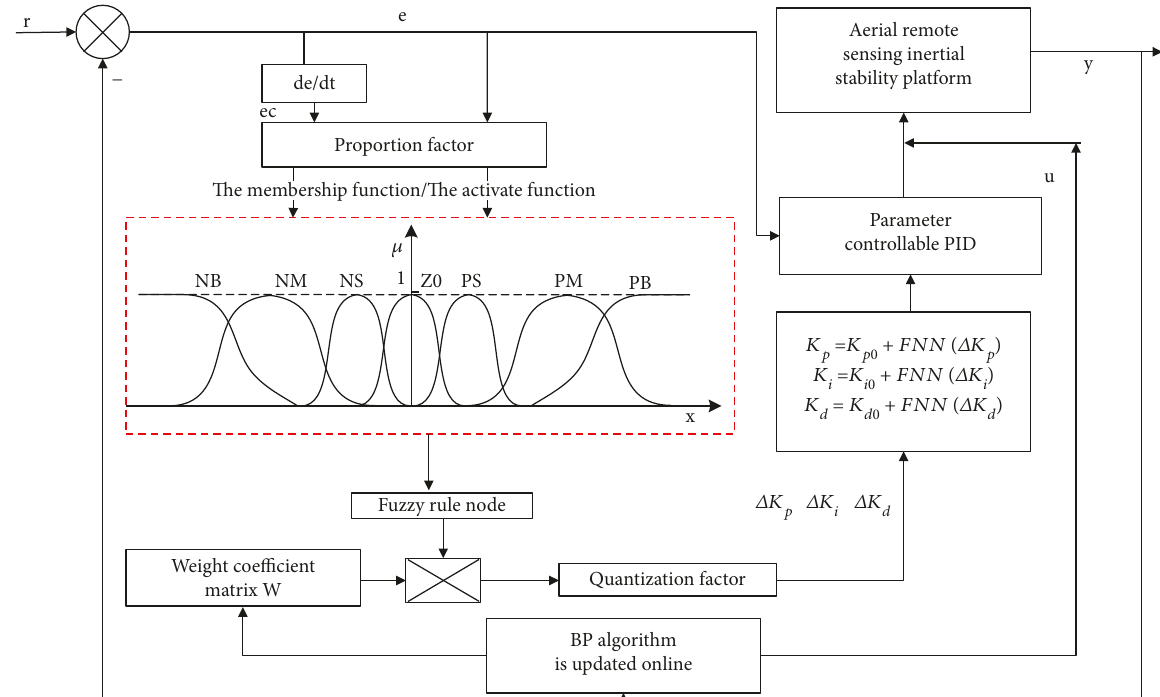
Figure 9: Schematic diagram of an improved FNN/PID compound control structure.